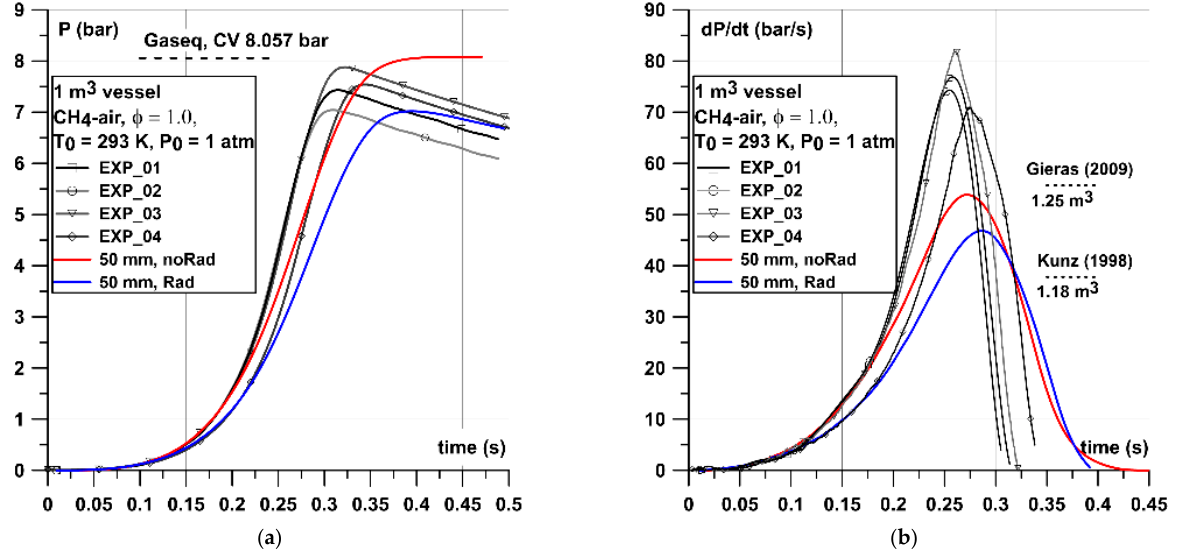
Figure 9. ( a ) Pressure and ( b ) dP/dt graphs for stoichiometric CH 4 –air mixture in the 1 m 3 vessel. Dotted lines mark (dp/dt) max values provided by Gieras [39] and Kunz [40] in the vessels of a similar volume and shape.